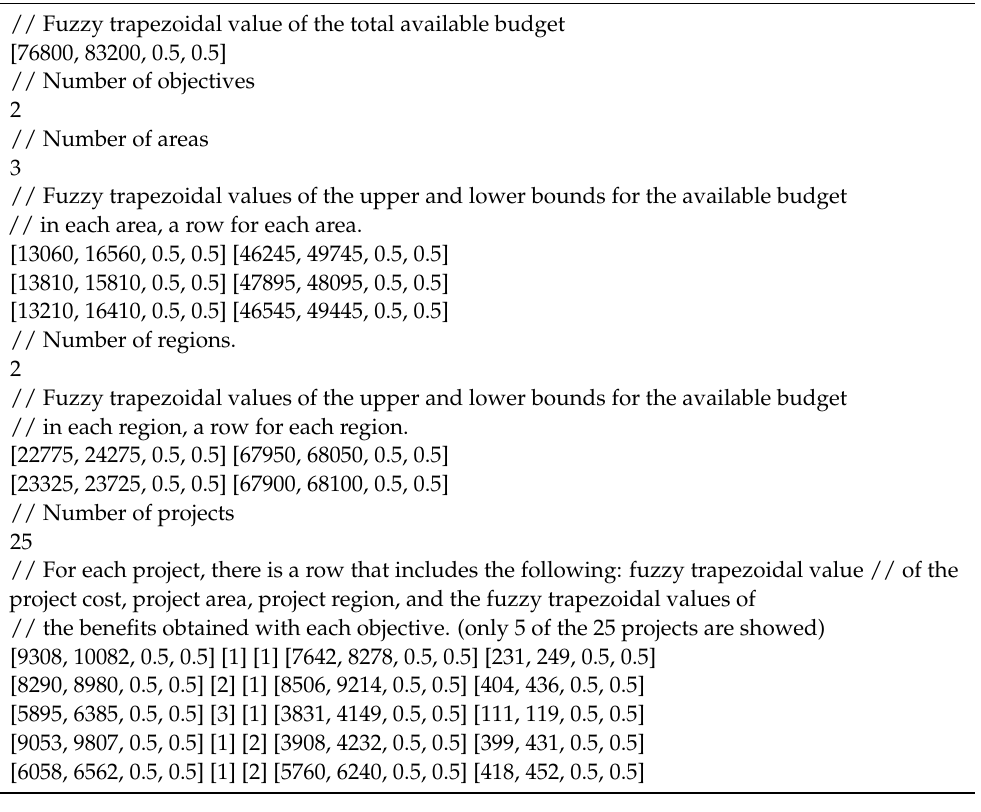
Algorithm 2. o2p25_0T fuzzy trapezoidal